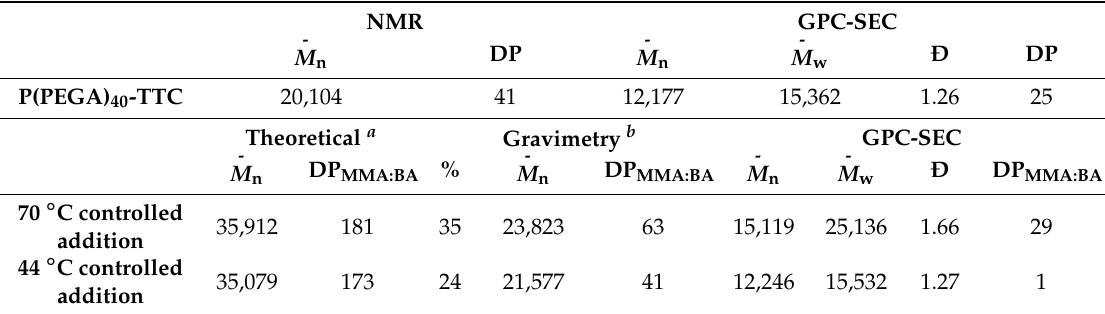
− M n and degree of polymerization of macroRAFT and